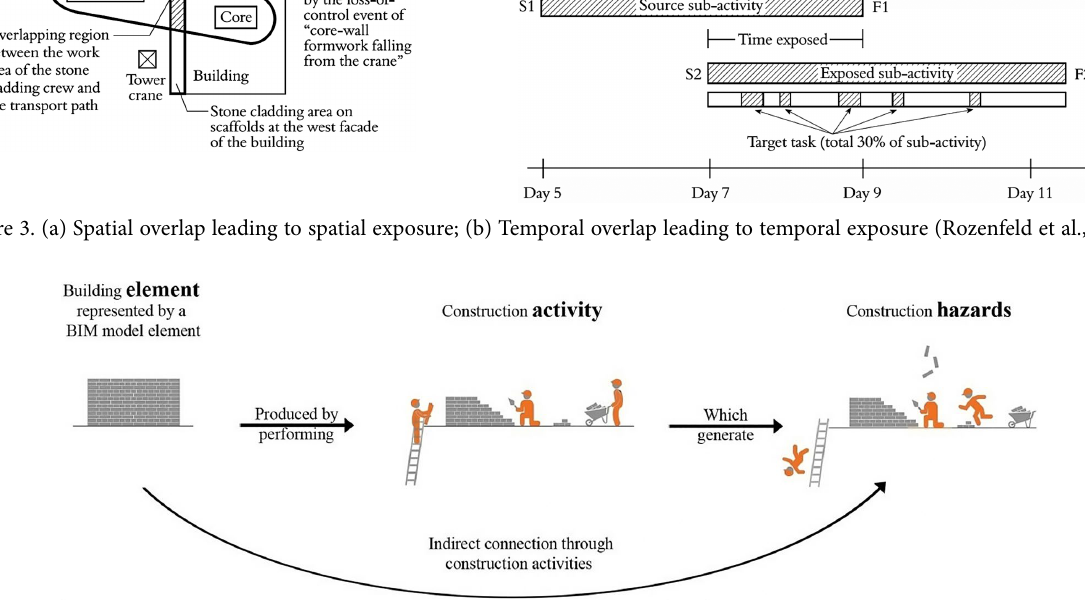
Figure 4. Indirect connection of building elements and construction hazards through construction